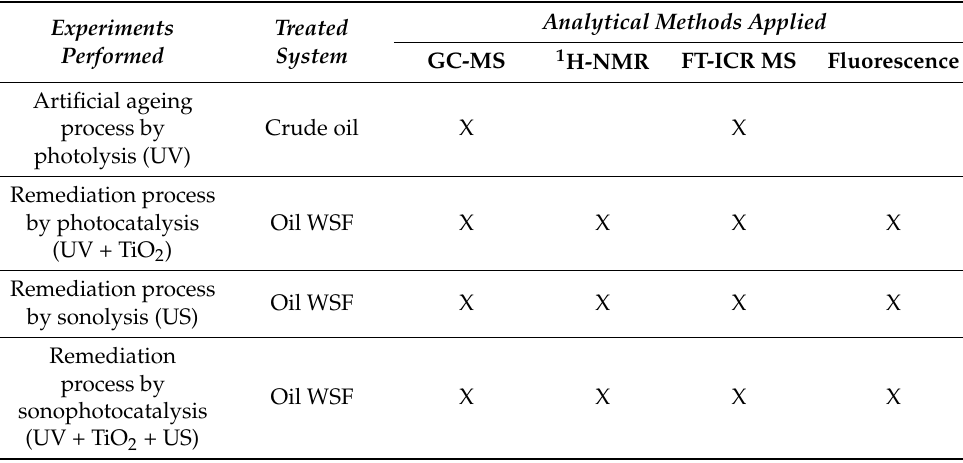
Table 4. Experiments performed and analytical methods used in this